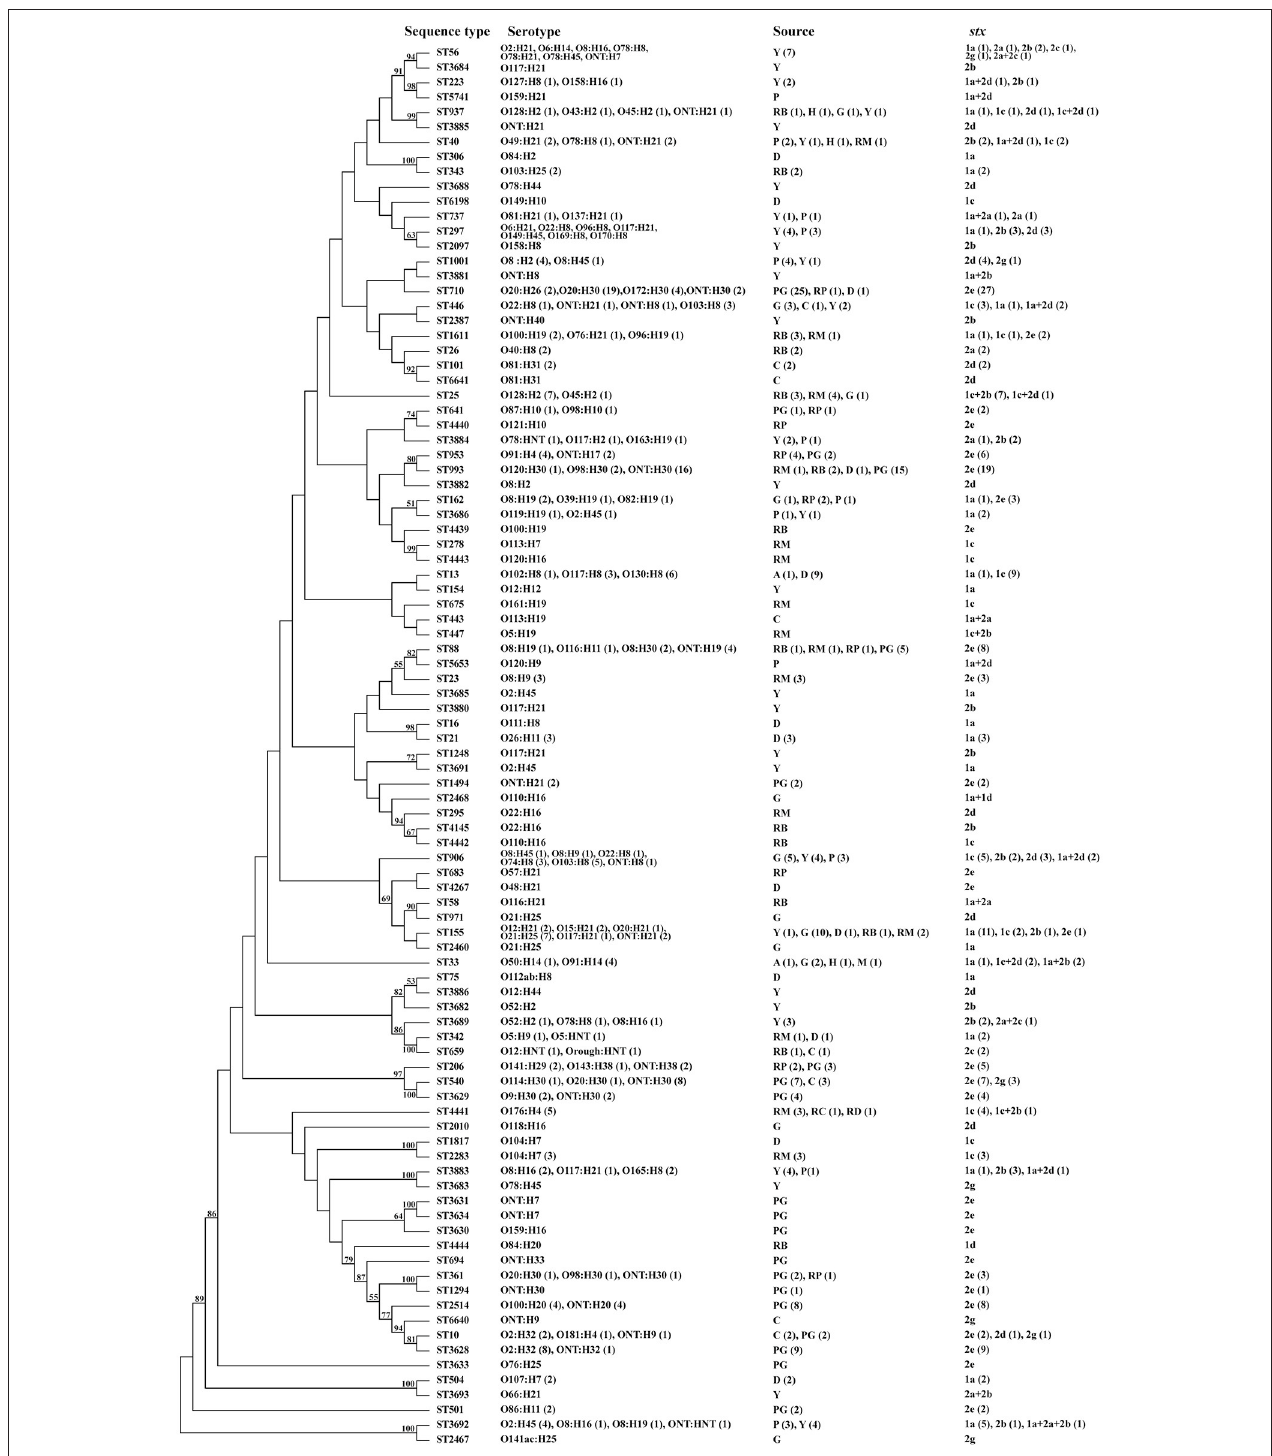
FIGURE 1 | Phylogenetic tree based on concatenated sequences of seven housekeeping genes of all 301 isolates by the Neighbor − joining method using MEGA 6. Numbers on the tree indicate bootstrap values calculated for 1000 subsets for branch points > 50%. For sequence types that consisted of more than one isolates, the number of isolates for individual profiles is provided in brackets. a Origin of isolation: Y, yak; P, pika; A, antelope; C, cattle; G, goat; PG, pig; D, diarrheal patients; H, healthy carriers; RB, raw beef; RM, raw mutton; RP, raw pork; RC, raw chicken; and RD, raw duck.